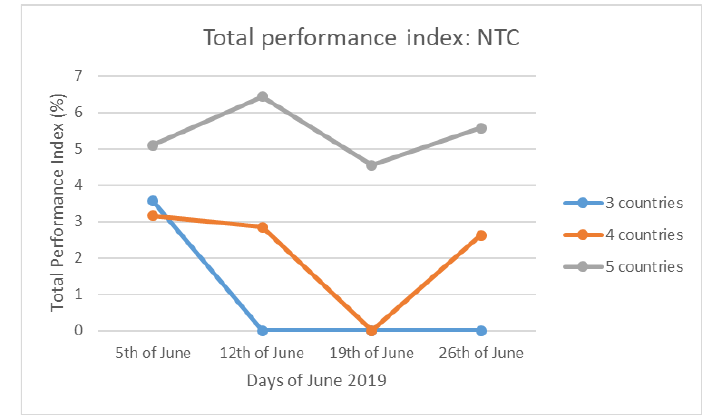
Figure 11. Total performance index calculated for NTC method.